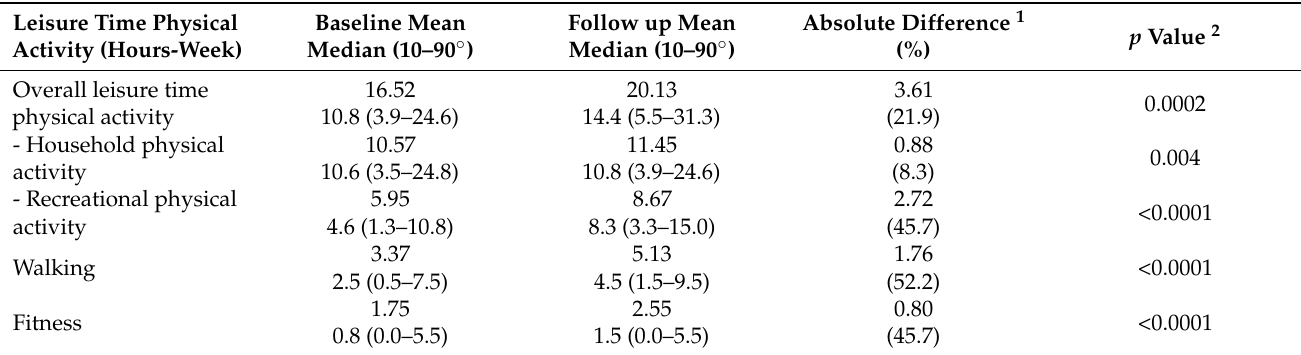
Table 5. Estimated changes in leisure time PA (hours/week) at the end of the intervention (The DAMA25 study, Florence, Italy, 2016–2017).